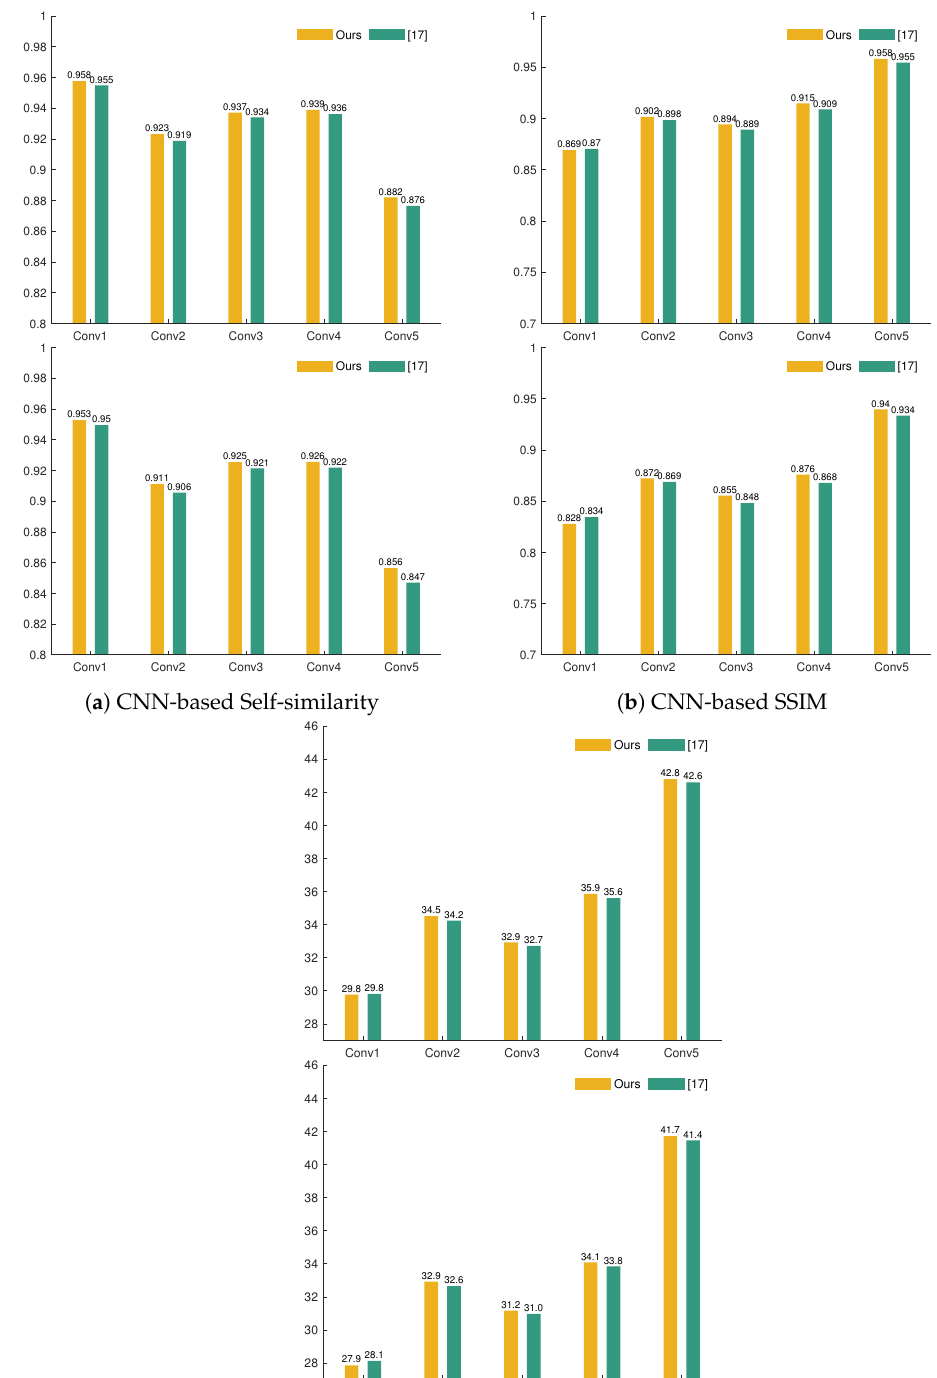
Figure 14. Bar plots showing the performance of three CNN-based IQMs for each convolutional layer. These metrics measure the similarity of the feature maps given by the activations of AlexNet (pre- trained on ImageNet) for the ground-truth test images and images inpainted by our approach and [17]. Top for each pair: the results for RW damage. Bottom for each pair: results for RW+DIL